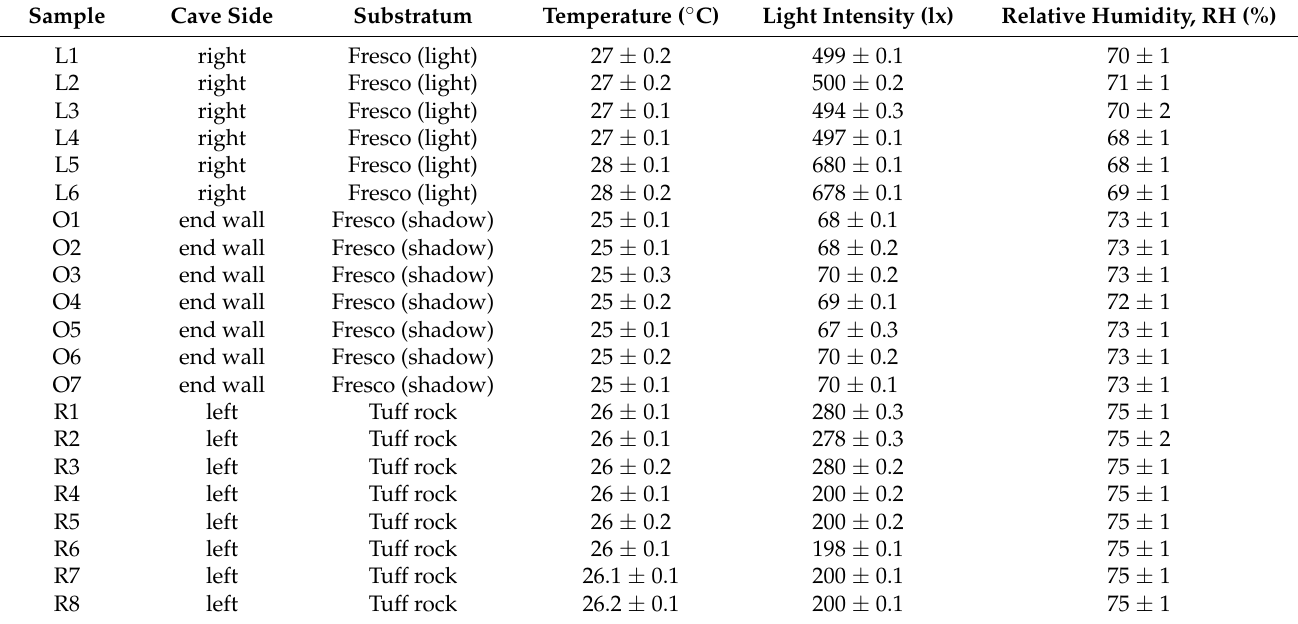
Table 1. Sampling points at Fornelle cave, with measures of corresponding environmental parameters on the tested samples.